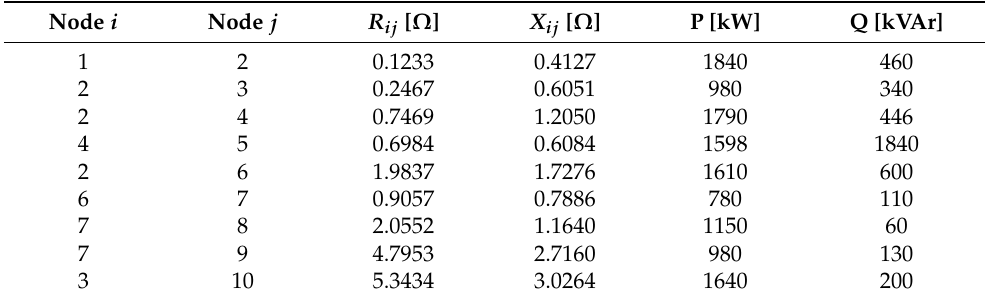
Table 3. Electrical parameters of the 10-node radial test system. Node